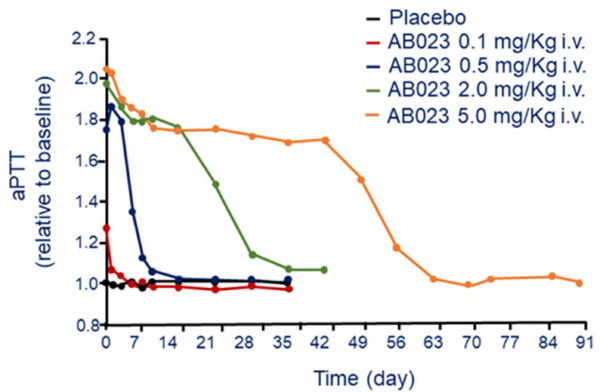
Figure 4. Dose-dependent effect of AB 023 on aPTT following a single i.v. administration. Modified from Lorentz, C.U. et al. [27]. aPTT: activated partial thromboplastin